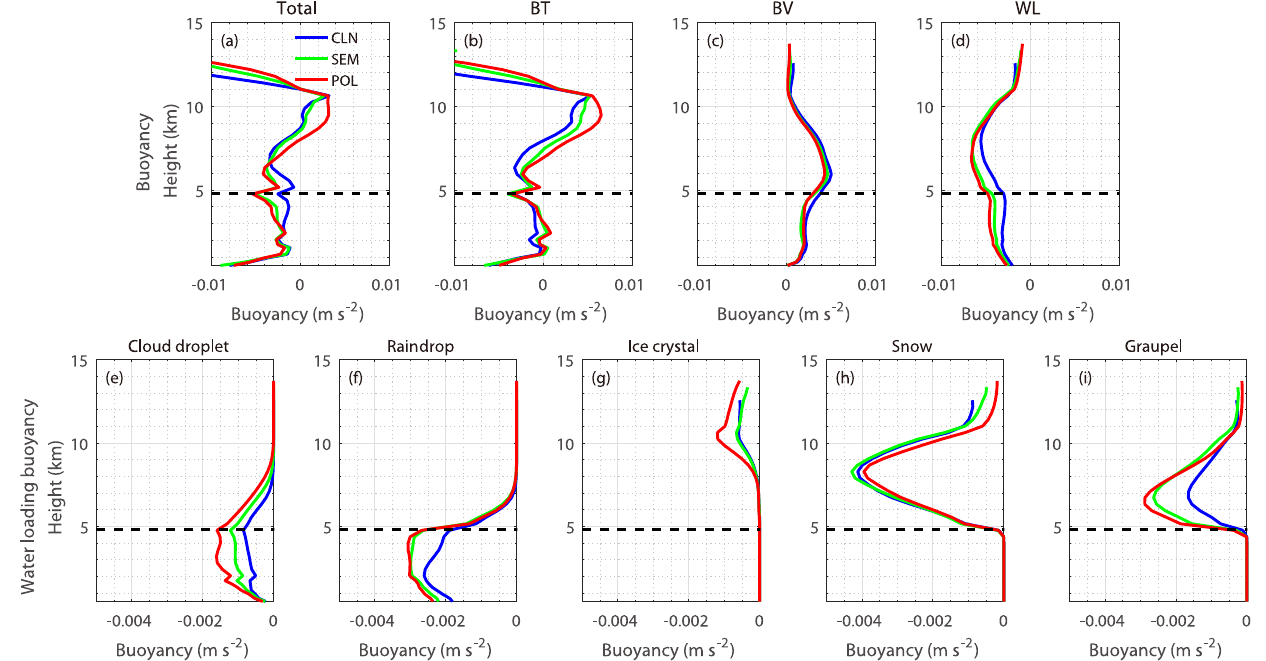
Figure 7. Vertical profiles of (a) mean buoyancy averaged over cloudy regions during 4–12h of the simulation and its components: (b) ther- mal term (BT), (c) water vapor term (BV), and (d) water loading term (WL). (e–i) Vertical profiles of WL for cloud droplet (e) , raindrop (f) , ice crystal (g) , snow (h) , and graupel (i) . The black dashed lines denote the ZTL ( ∼